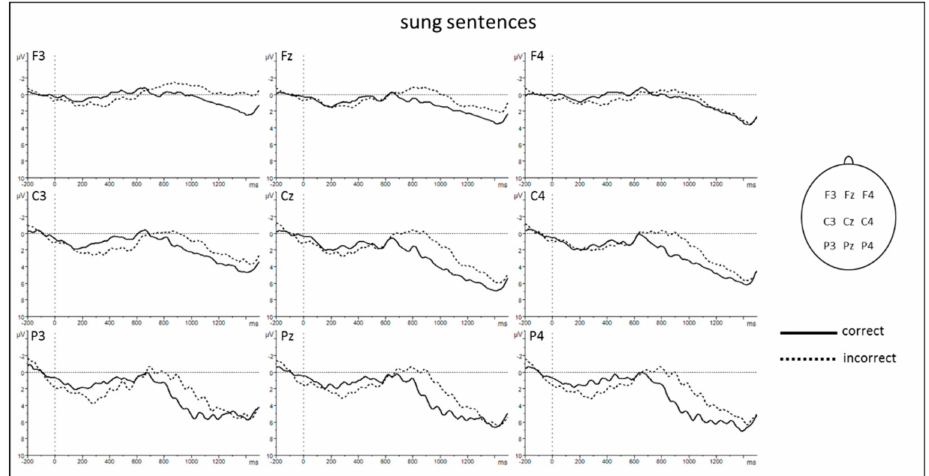
Figure 4. ERP results for sung sentences. Grand averages from − 200 ms to 1500 ms after verb onset. Negativity is plotted upwards. An 8 Hz low-pass filter was applied for presentation purposes